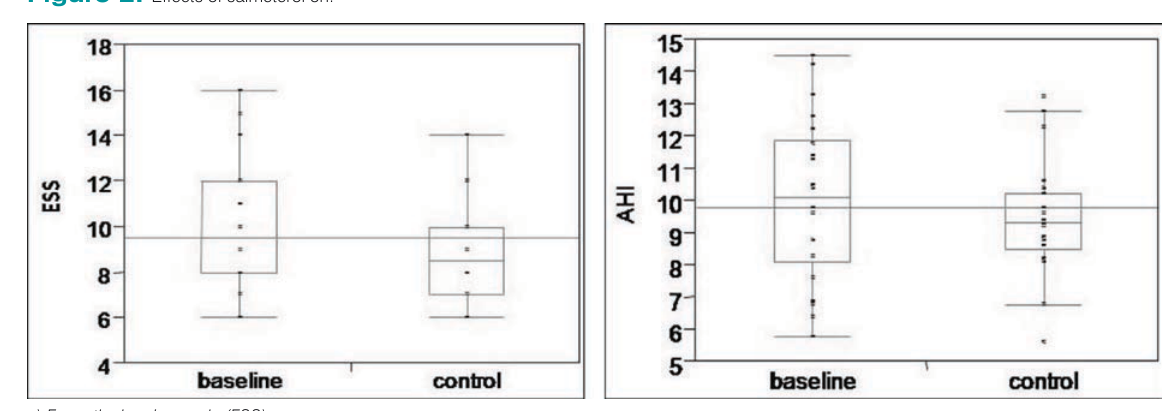
Figure 2. Effects of salmeterol on: